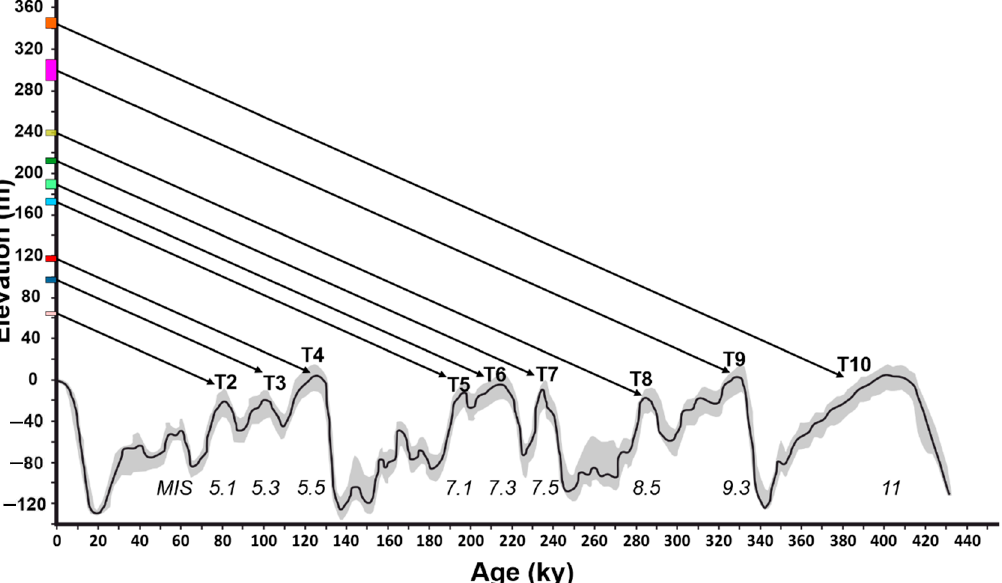
Figure 6. Chronological correlations between observed marine terraces and sea level peaks of the [56] sea level curve (bold black line). The light grey area marks the associated confidence interval. Numbers in italics indicate the marine isotopic stage (MIS). The colored rectangles along the ordinate axis point at the present day elevation range of the inner edges of different terrace orders (the colors are the same as in Figure 2). The solid arrow marks the expected chronological correlation, based on an average uplift rate of 1